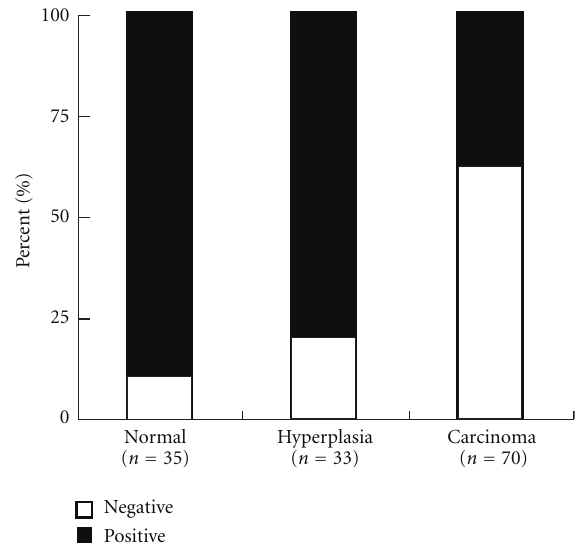
Figure 2: Overall level of Wnt7a expression in normal endome- trium, hyperplastic endometrium and endometrial carcinomas according to the immunohistochemical result (endometrial car- cinoma versus normal endometrium: P < 0 . 001; endometrium carcinoma versus hyperplastic endometrium: P < 0 .